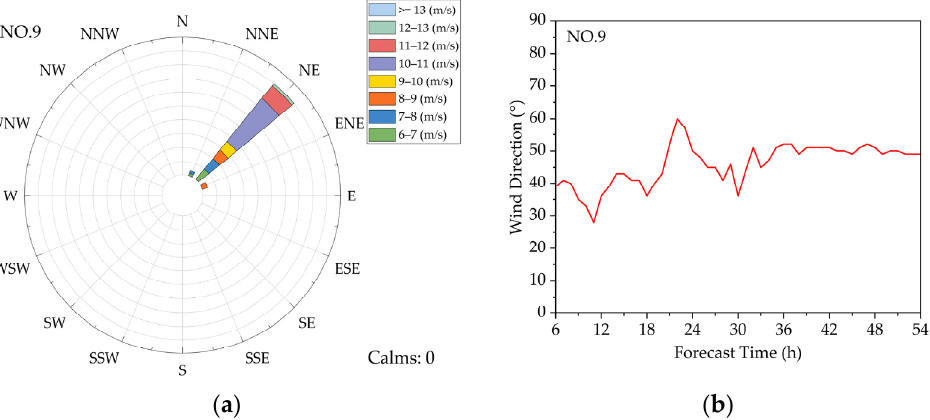
Figure 6. A description of the wind direction during the simulation period: ( a ) the wind rose of NO.9 turbine on the hub height; ( b ) wind direction varies with time.